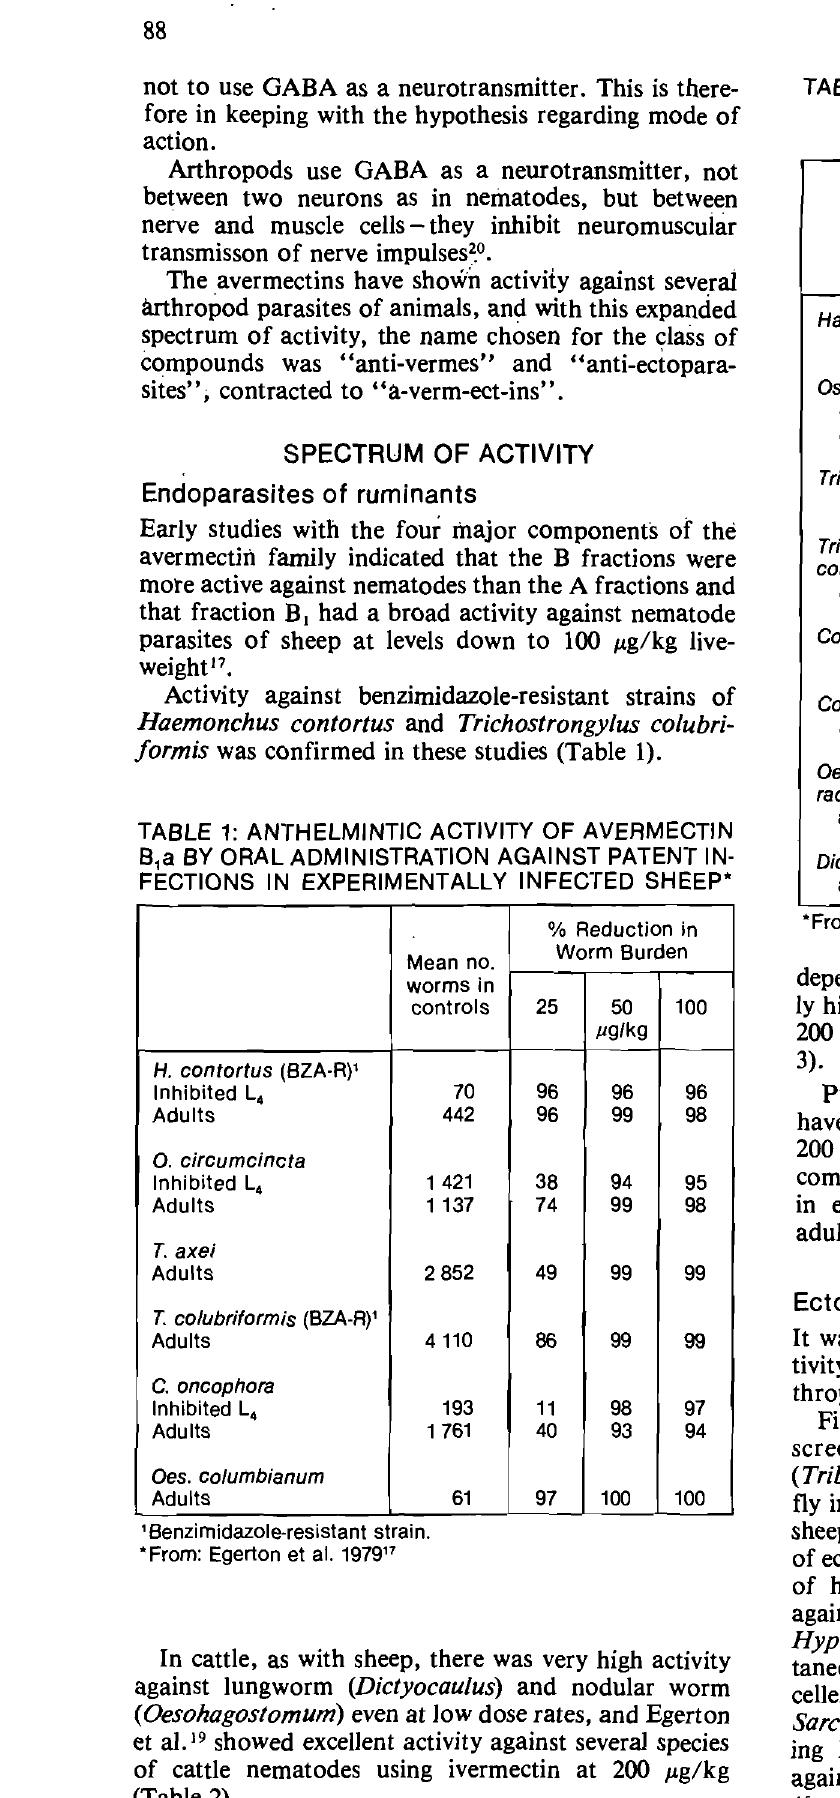
TABLE 2: ANTHElMINTIC EFFICACY OF IVERMECTIN AS A SINGLE SUBCUTANEOUS DOSE AGAINST EXPERIMENTAL INFECTIONS IN CADLE" Mean.